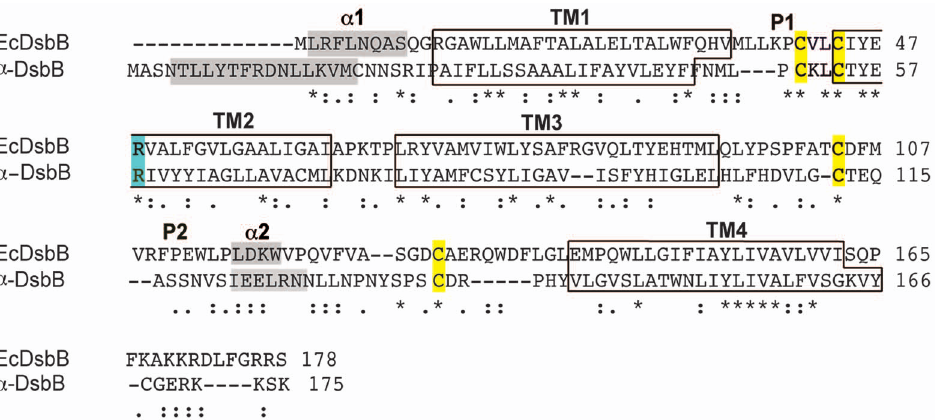
Figure 1. a -DsbB is helical with a predicted topology similar to that of EcDsbB. Sequence-based secondary structure prediction for a -DsbB was derived using Topcons [39], TMHMMfix [40] and PsiPred [42] and the EcDsbB secondary structure was derived from the crystal structure [49]. a - DsbB and EcDsbB both have four conserved cysteine residues (highlighted in yellow), two in each periplasmic loop. The four transmembrane regions of each protein, TM1–TM4, are boxed. Another two helices are present in EcDsbB ( a 1 at the N-terminus and a 2 in loop P2, grey boxes) [56], and these were also predicted in a -DsbB, though the N-terminal helix is much longer than in EcDsbB. Arg48 of EcDsbB and Arg58 of a -DsbB are highlighted in cyan; this residue binds the quinone cofactor in EcDsbB. The sequence alignment of the two proteins was performed using ClustalW [57] with manual adjustments to align loop cysteines and predicted TM helices.